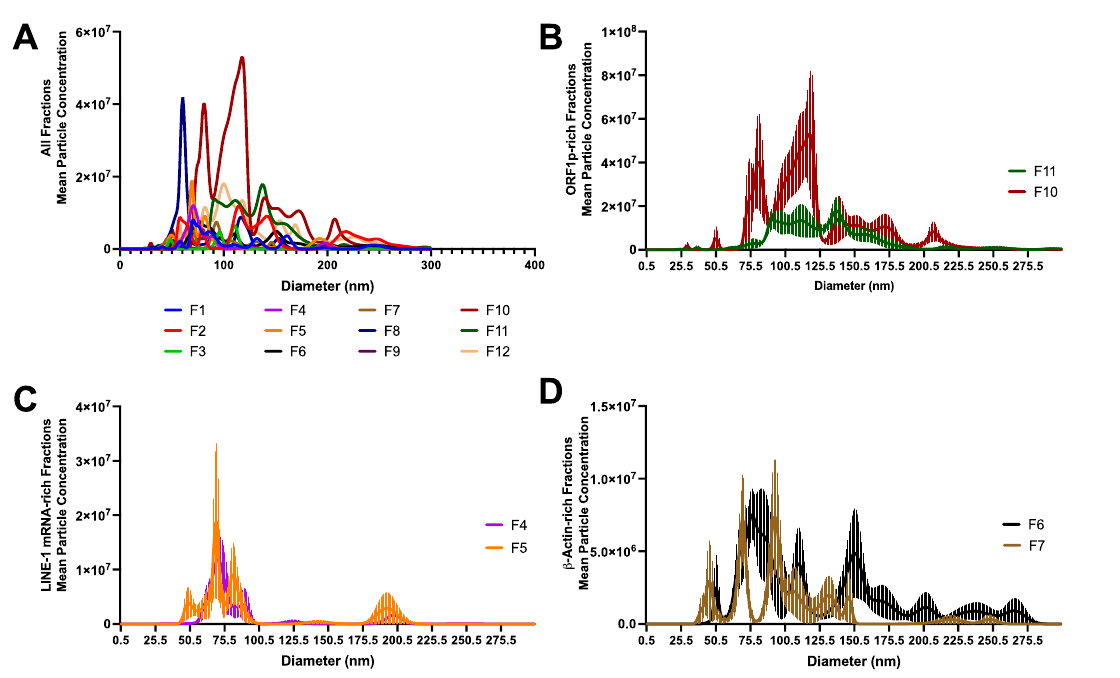
Figure 3. Characterization of Long Interspersed Element-1 (LINE-1)-containing extracellular vesicles (EVs). We examined EVs from the density gradient fractions shown in Figure 2 using Nanosight Nanoparticle tracking analysis (NTA). ( A ) NTA profiles of all fractions. ( B ) ORF1p-rich fractions. ORF1p was consistently found in EVs with a density greater than ~1.12 g/mL, most often in Fractions 10 and 11 (~1.16 – 1.2 g/mL). ( C ) LINE-1 mRNA-rich fractions. LINE-1 mRNA was detected in EVs